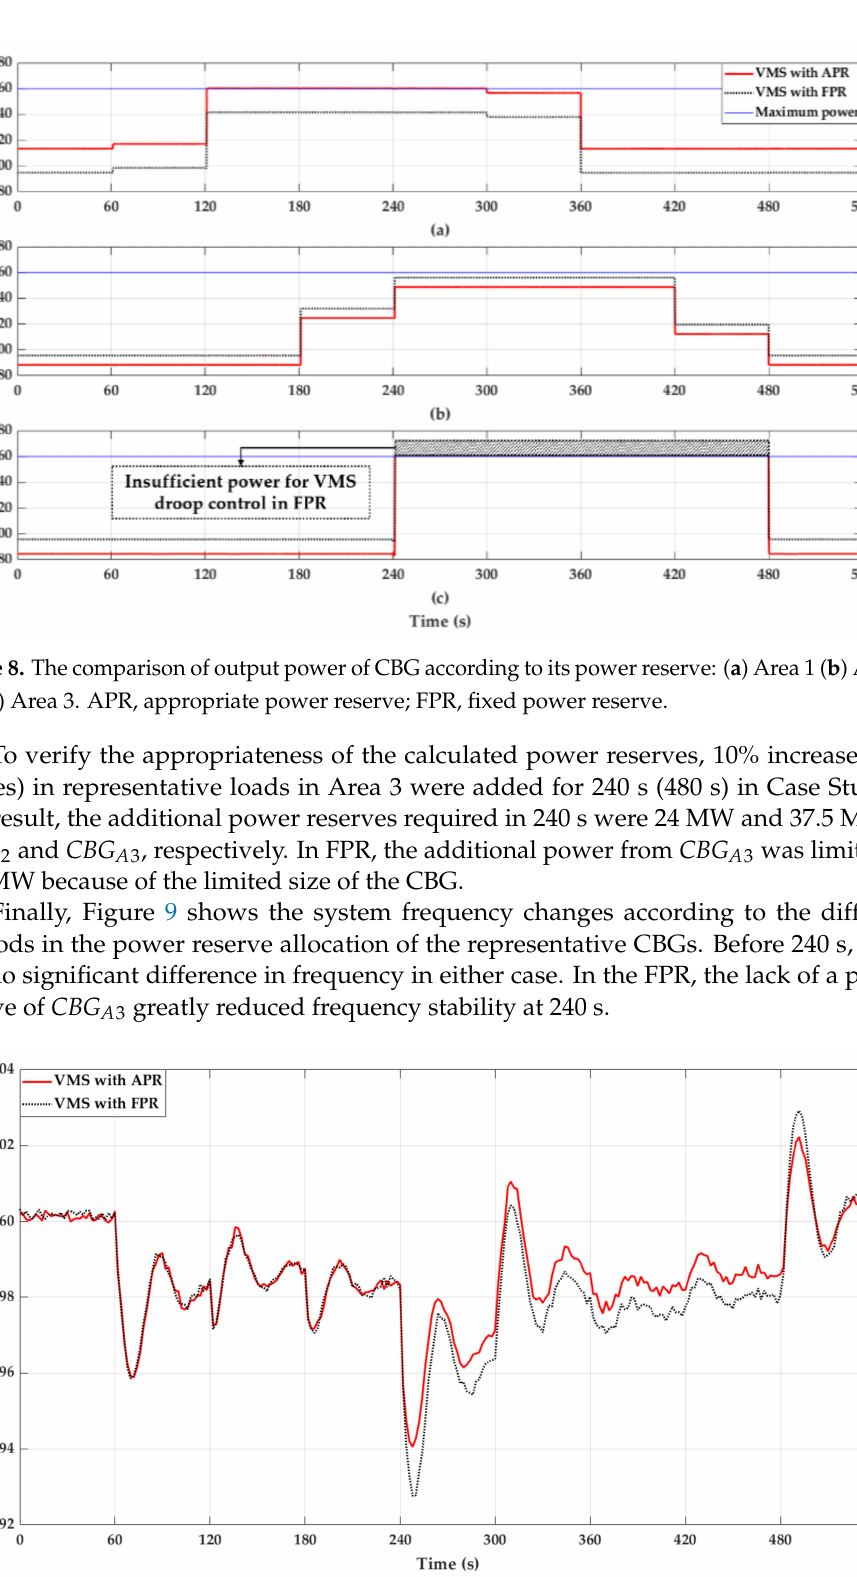
Figure 9. The frequency responses according to the power reserve allocation methods of